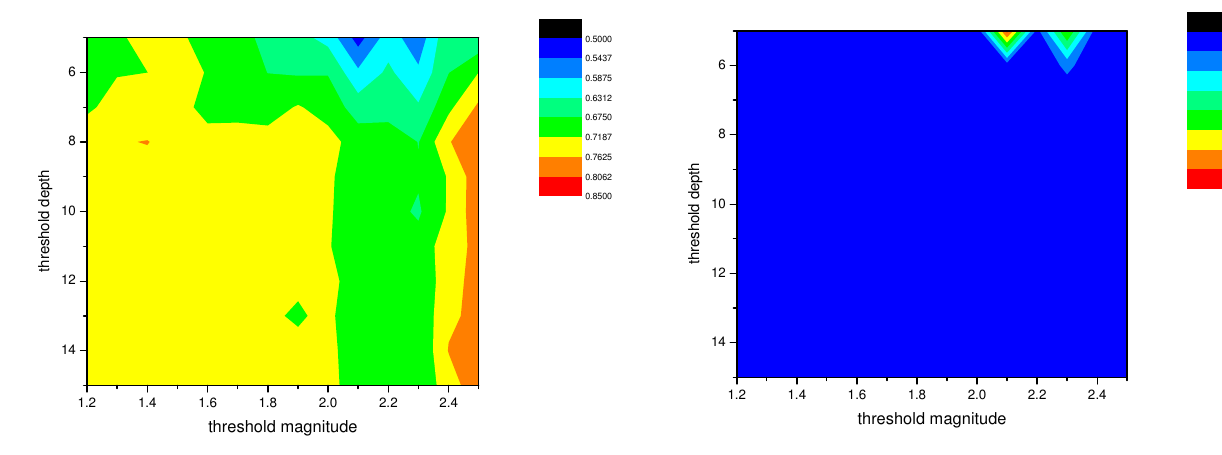
Fig. 11. p-values for the interdistance time series changing the threshold magnitude and